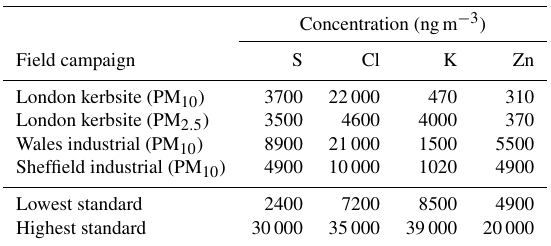
Table 2. Maximum concentration in field campaigns (ngm − 3 ) and highest and lowest concentration used in calibration